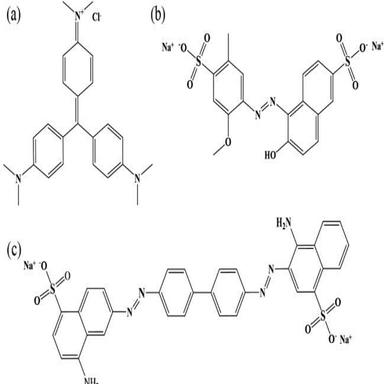
Chemical structures of dyes (a) methyl violet, (b) allura red and (c) congo red.